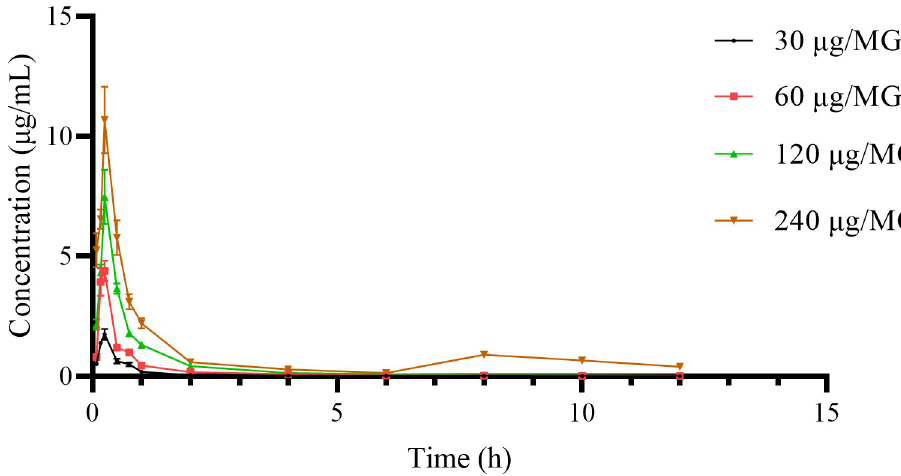
Fig 2. Plot of plasma concentrations of cefquinome versus time in a mouse model of S . agalactiae mastitis (n = 6) following a single intramammary administration of 30 μ g/MG, 60 μ g/MG, 120 μ g/MG, and 240 μ g/MG. The bars represent the standard deviations. The cefquinome concentration in plasma was determined by LC-ESI-MS/MS as described in the method section.